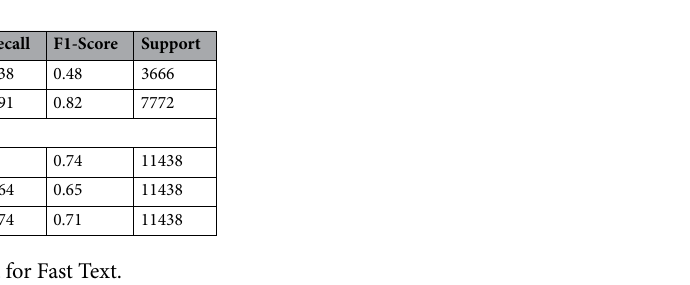
Table 3. Classification report for Fast